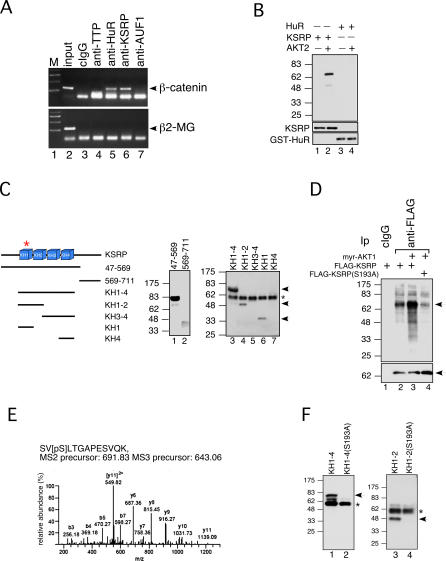
KSRP Is Phosphorylated by AKT in Serine 193(A) Immunoprecipitation of β-catenin RNA-containing ribonucleoprotein complexes. The proteins were immunoprecipitated from αT3-1 total cell extracts using the indicated antibodies. RNA was extracted from the immune complexes and analyzed by RT-PCR as indicated.(B) Either highly purified recombinant human KSRP (lanes 1 and 2) or affinity-purified GST-HuR (lanes 3 and 4) was incubated with either active recombinant AKT2 in kinase buffer or buffer alone in the presence of [γ-32P]ATP. Labeled proteins were separated by SDS-PAGE, blotted to nylon membranes, and detected by autoradiography (top panel). Immunoblot analysis of the above kinase reactions with either anti-KSRP (middle panel) or anti-GST (bottom panel) antibodies.(C) Schematic representation of KSRP and GST-fused deletion mutants. Asterisks indicate the position of a putative AKT phosphorylation site (left). AKT2 kinase assays were performed using the indicated recombinant protein substrates (middle and right). Arrows point to the position of each phosphorylated protein; the asterisk marks the position of phosphorylated AKT2.(D) In vivo [32P]orthophosphate metabolic labeling of HeLa cells transiently cotransfected with either FLAG-KSRP plus empty pcDNA3, or FLAG-KSRP plus pCMV–myr-AKT1, or FLAG-KSRP(S193A) plus pCMV–myr-AKT1. Aliquots of the lysates were immunoprecipitated with protein A–protein G–Sepharose–bound mouse control IgG (cIgG) or anti-FLAG antibody, separated by SDS-PAGE, and autoradiographed (top panel). Immunoblot analysis of the above in vivo phosphorylation reactions with anti-FLAG antibody (bottom panel). Arrows point to the position of transfected KSRP.(E) MS-MS fragmentation spectrum of the tryptic peptide SV[pS]LTGAPESVQK of KSRP showing phosphorylation of S193.(F) AKT2 kinase assays using the indicated recombinant protein substrates. Arrows point to the position of each phosphorylated protein; the asterisk marks the position of phosphorylated AKT2.